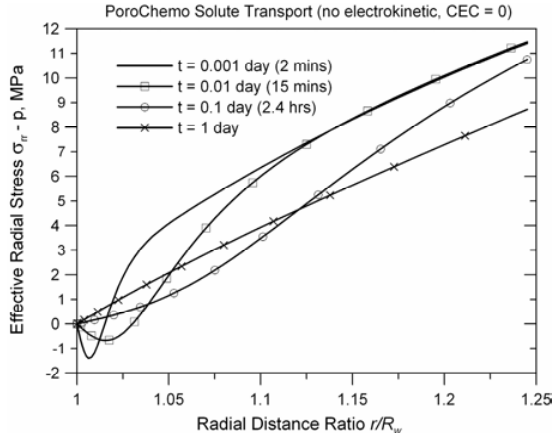
Fig. 6 – Effective tangential stress distribution in the formation after t = 15 minutes into drilling for high mud activity (low mud f . 93 > a f . 90. salinity): a o = 0 mud = 0